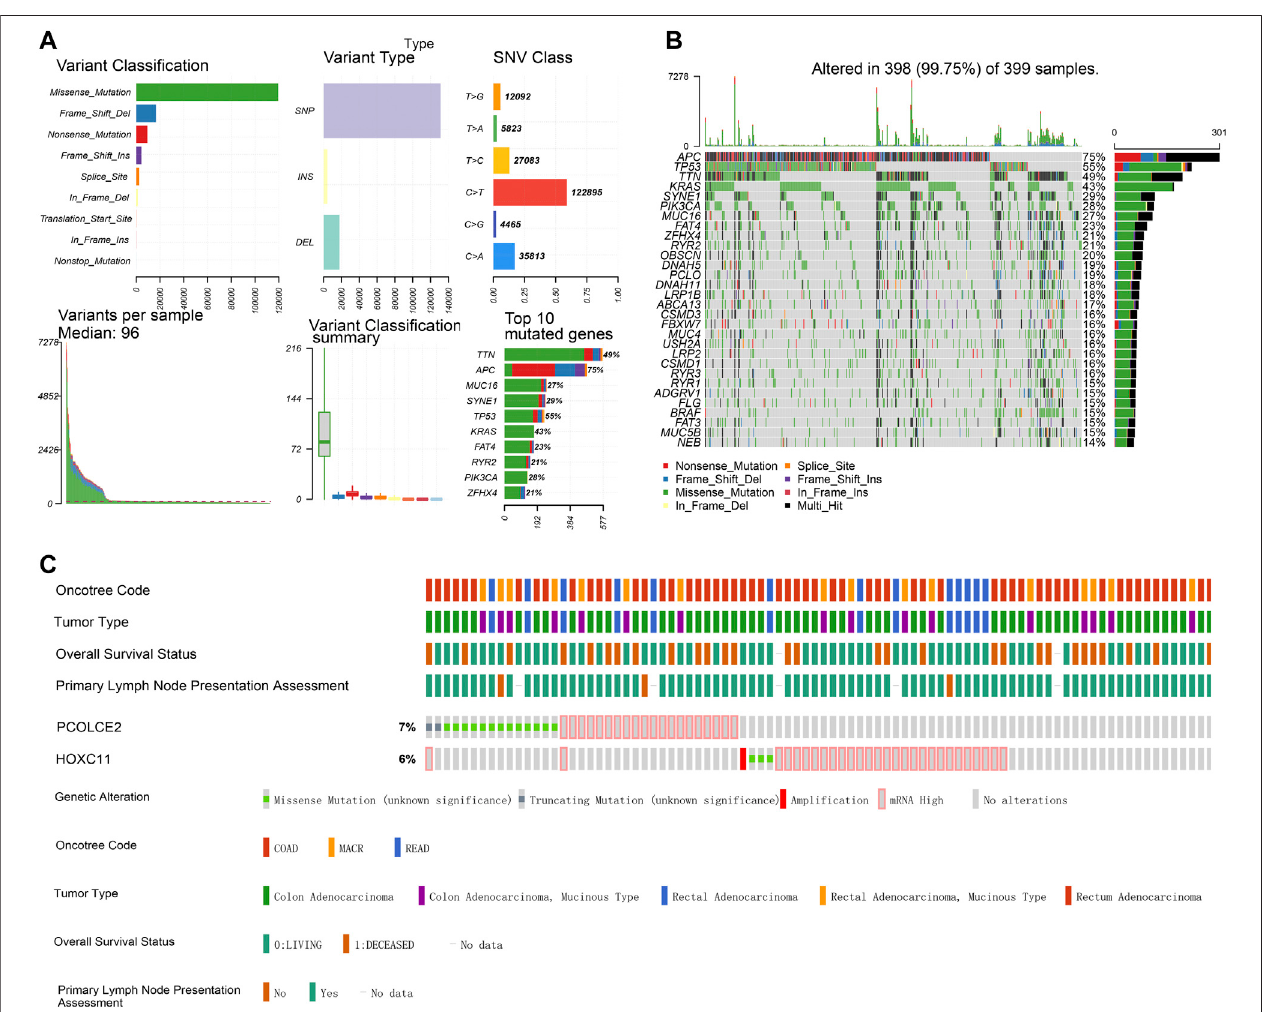
FIGURE 7 | Single-nucleotide variation (SNV) and copy number variation (CNV) of targeted genes in TCGA samples. Percentage and types of SNV of COAD samplesinTCGAdatasets (A) .ToprankinggeneswithhighpercentageofSNVinhighriskscoregroupofCOADsamplesinTCGAdatasets (B) .ThepercentageofCNV of PCOLCE2, HOXC11 in COAD samples of TCGA (C) .